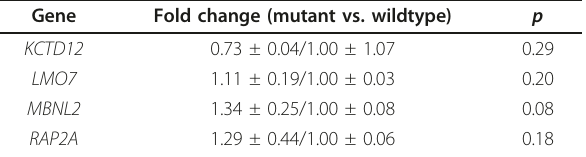
Data are represented as mean ± standard